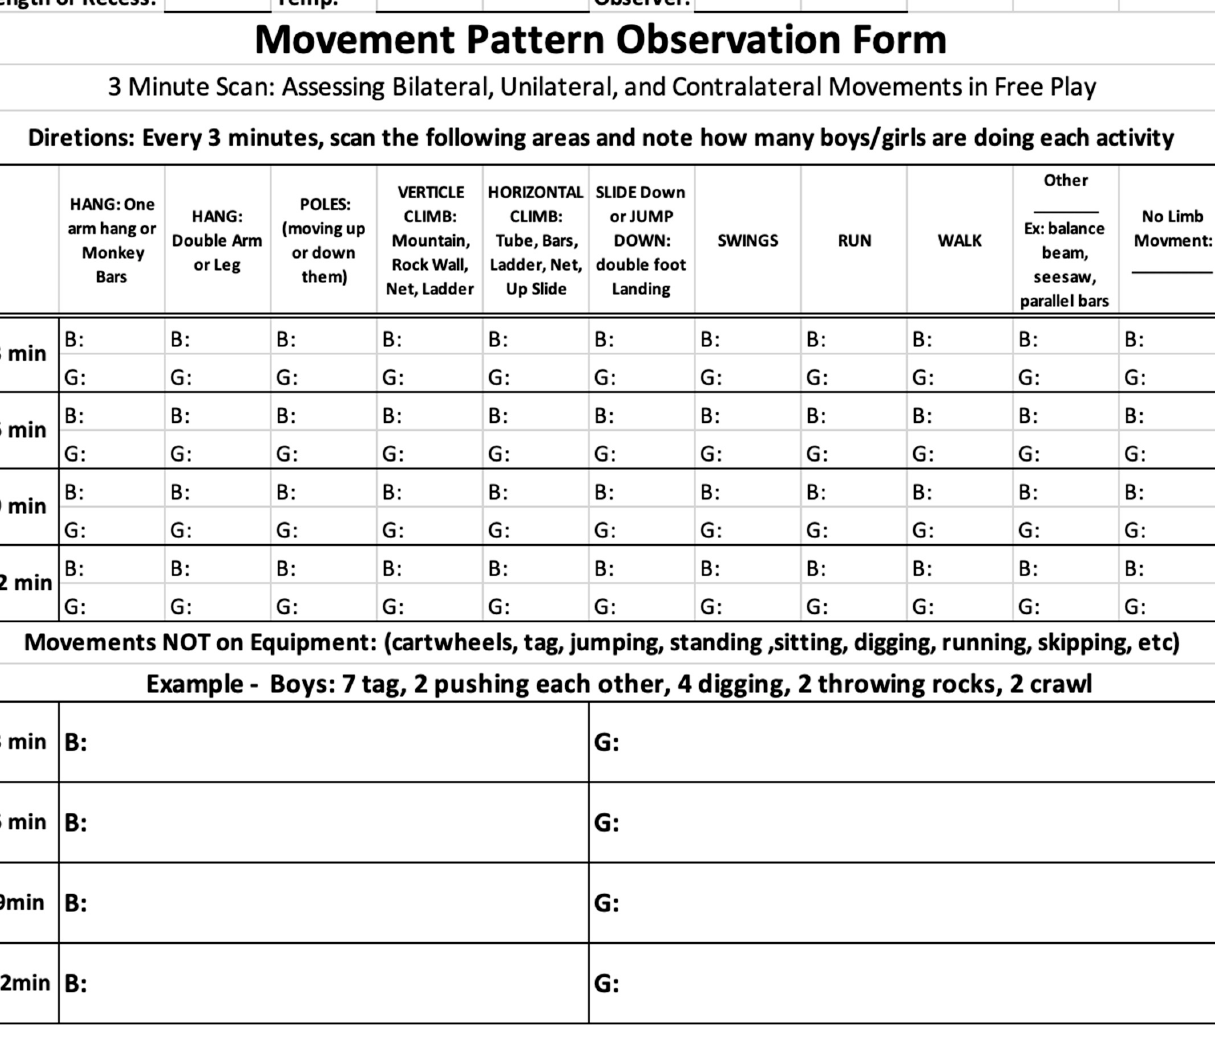
Figure 3. Final Movement Pa tt ern Observation Tool (MPOT).